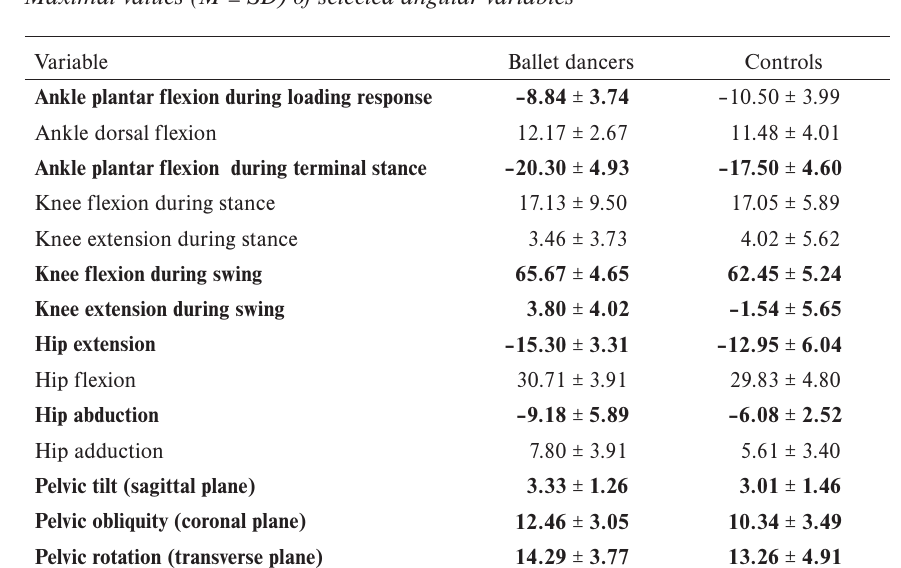
Maximal values (M ± SD) of selected angular